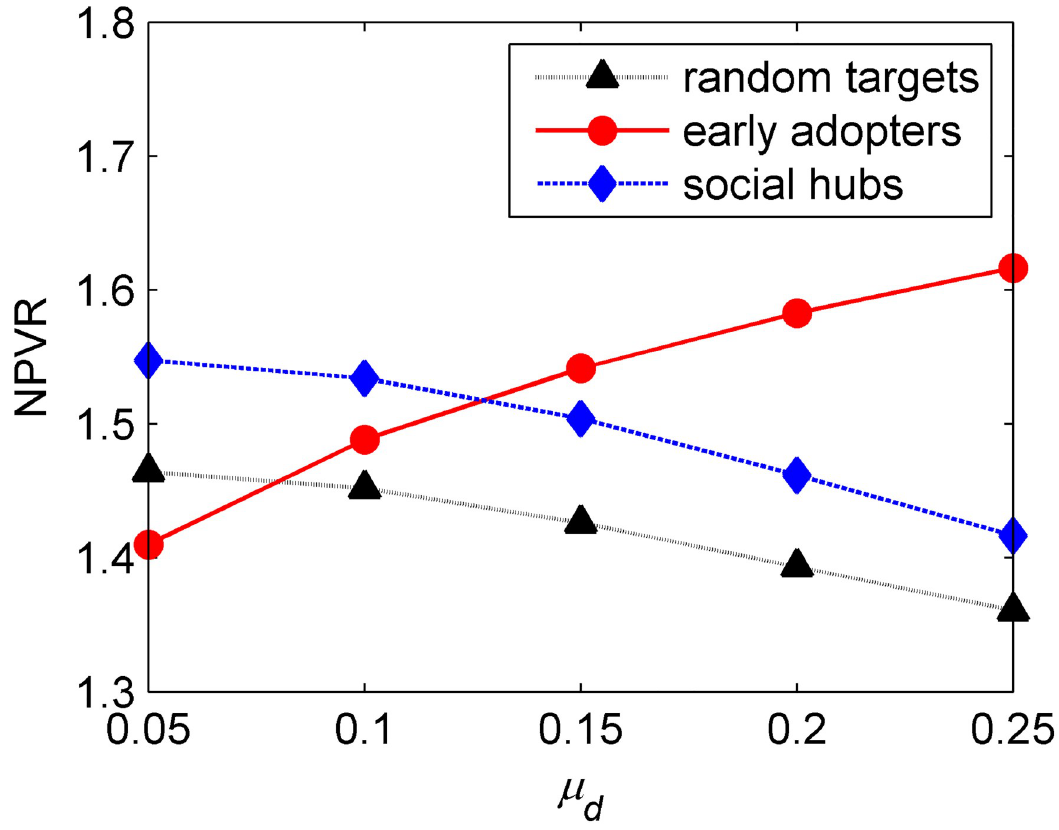
Fig 5. Influence of the mean value of the probability of spreading negative WOM on the three seeding targets. In Fig.5, the abscissa represents the average proportion of dissatisfaction, while the ordinate indicates the change in the ratio of net present value.